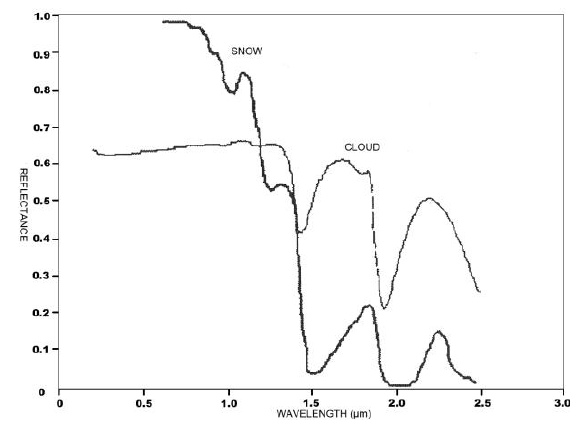
Figure 1. Spectral properties of snow and cloud But clouds seldom show all the properties at the same time. Thin clouds show a portion of the underlying surface spectral properties and low clouds are warmer than the background.